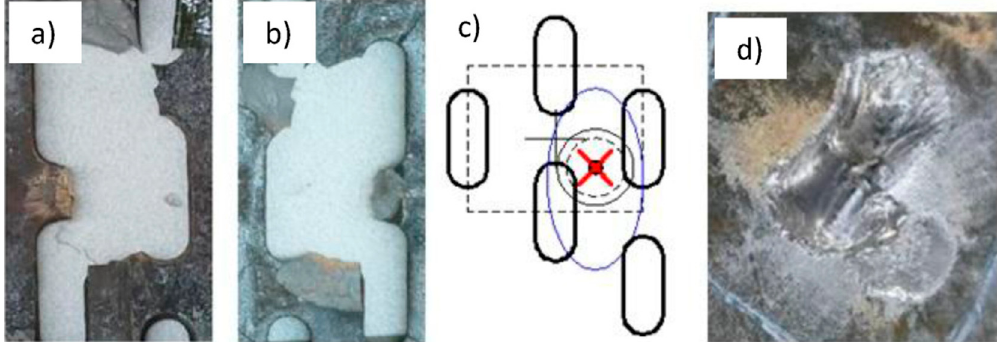
Figure 8. Damage of the perforated plate after the impact in an area between perforations: ( a ) front side; ( b ) rear side; ( c ) schematic view of the damaged area; ( d ) deformation of the base armour [43]. Reprinted with permission from Elsevier: Int. J. Impact Eng. , Copyright 2021, License: 5017590451474.